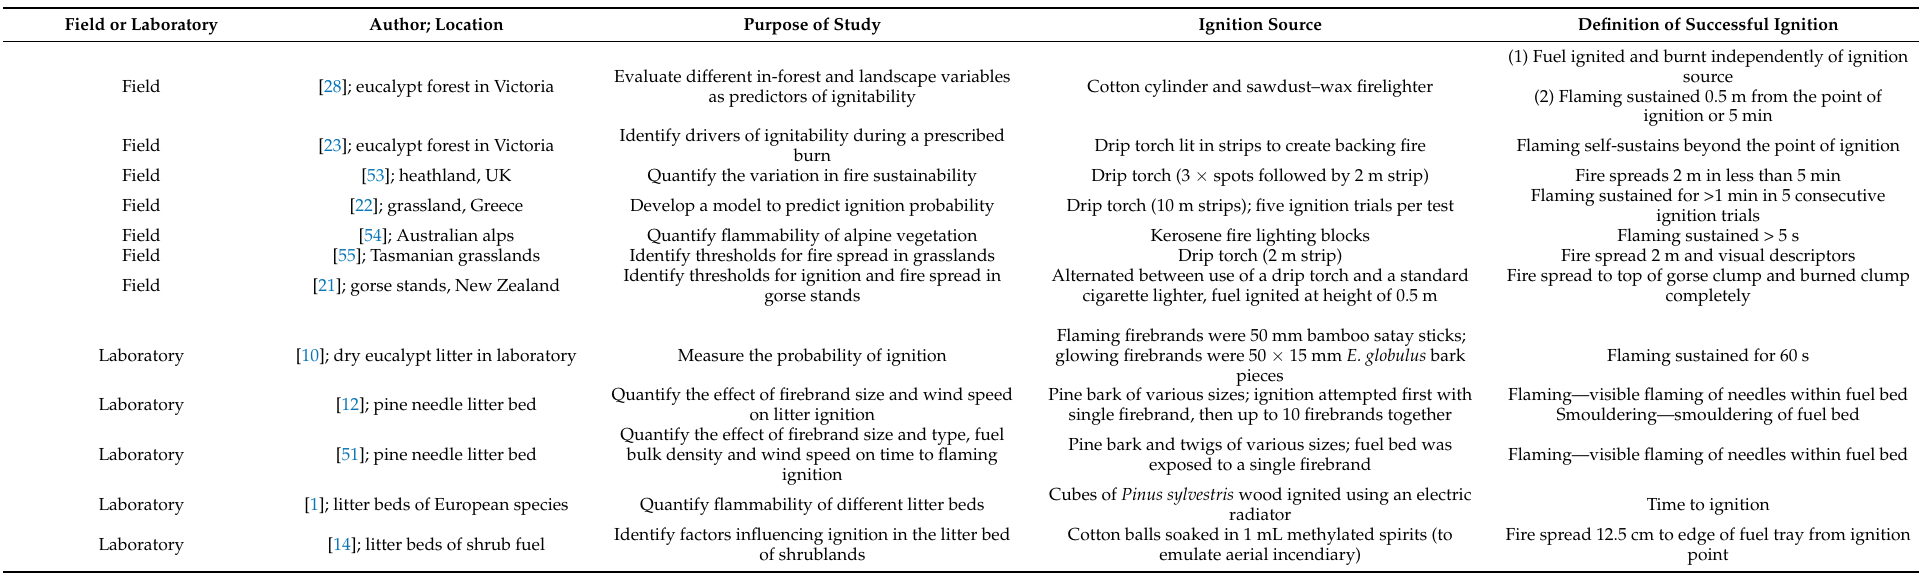
Table A1. Summary of past studies that investigate ignitability in the laboratory and field.